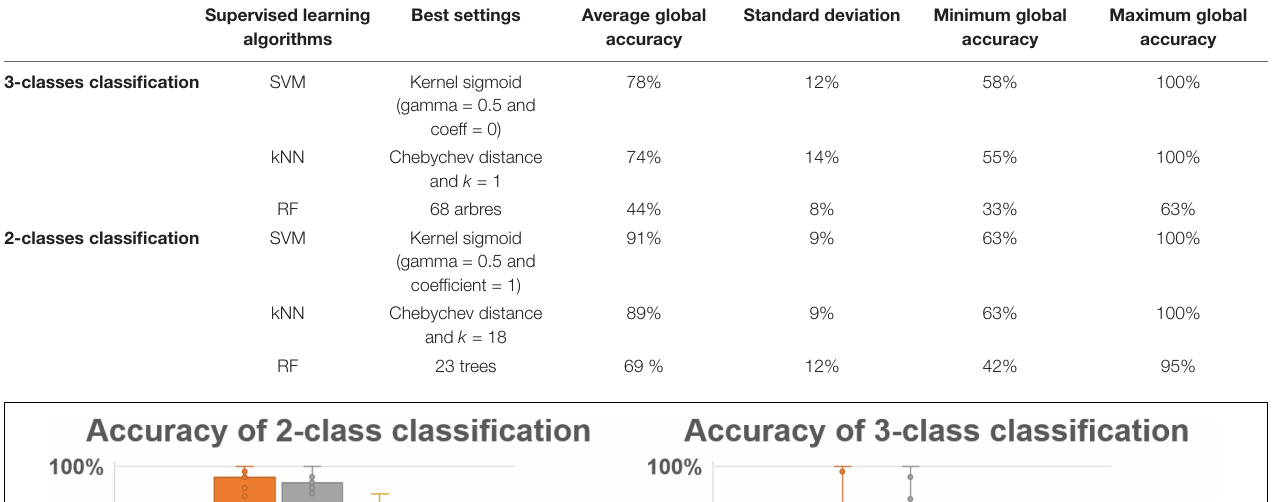
TABLE 4 | Accuracy of classification performed individually on each of the 17 participants.